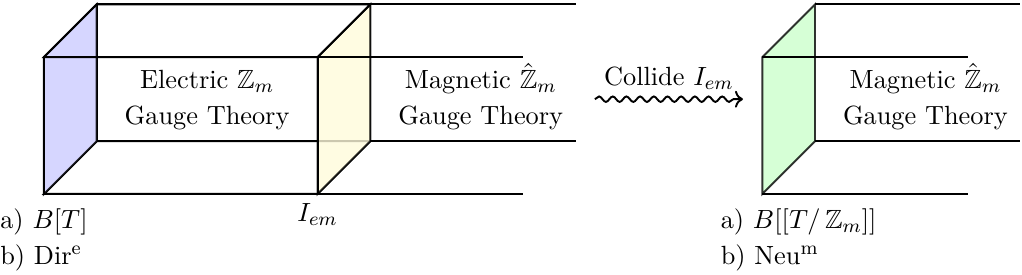
Figure 6 . On the left, a slab of Z m gauge theory and ˆ Z m gauge theory separated by an (invertible topological) electric-magnetic duality interface I em (yellow). If one moves the interface I em all the way to the left, then all that remains is ˆ Z m gauge theory with a new boundary condition (green). a) If the left boundary condition (blue) is an enriched Neumann boundary condition B [ T ] , then when it collides with the interface it appears as the enriched Neumann boundary condition B [[ T/ Z m ]] . b) If the left boundary condition (blue) is a Dirichlet boundary condition for the Z m gauge theory, then it appears as a Neumann boundary condition for the ˆ Z m gauge